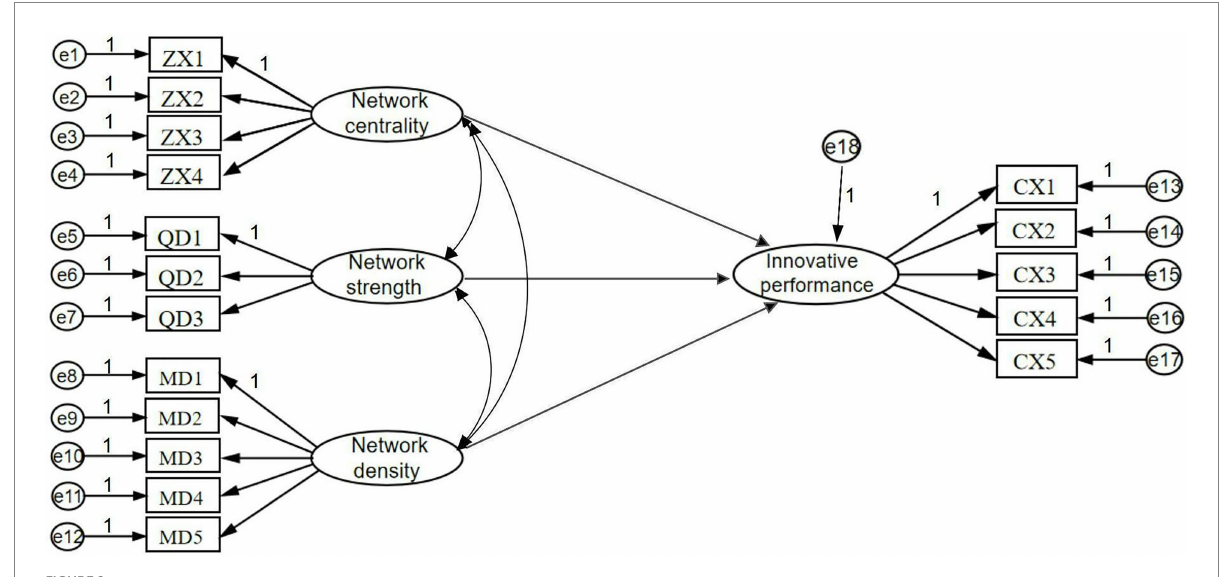
FIGURE 2 Structural equation model